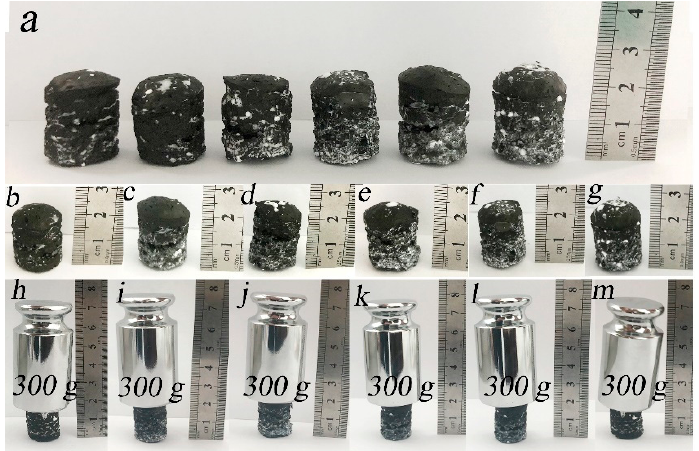
Figure 5. Compression test images of PVA–GA aerogel and PVA–GA–CNF ‐ (1–5) aerogel. ( a ) Appearance of PVA–GA aerogel and PVA–GA–CNF ‐ (1, 2, 3, 4, 5) aerogel. ( b – m ) Height changes of PVA–GA aerogel and PVA–GA–CNF ‐ (1–5) aerogel under 300 g mass, respectively.